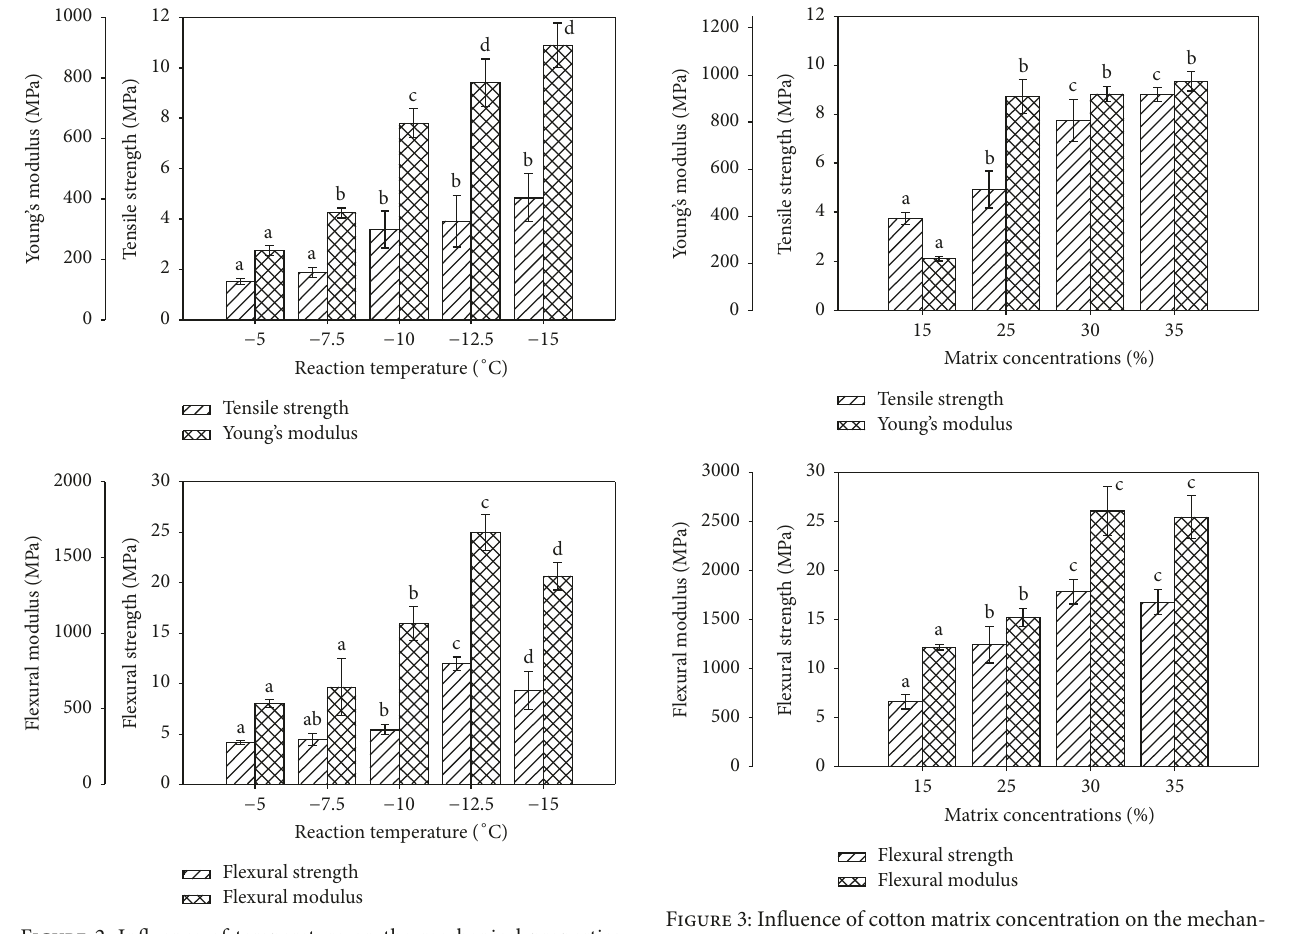
Figure 2: Influence of temperature on the mechanical properties of biocomposite composed of 25% cotton: 75% OOW. Treatment values with different letters for the same mechanical test are significantly different ( 𝑝 ≤ 0.05 ) following Duncan’s Multiple Range Test analysis.